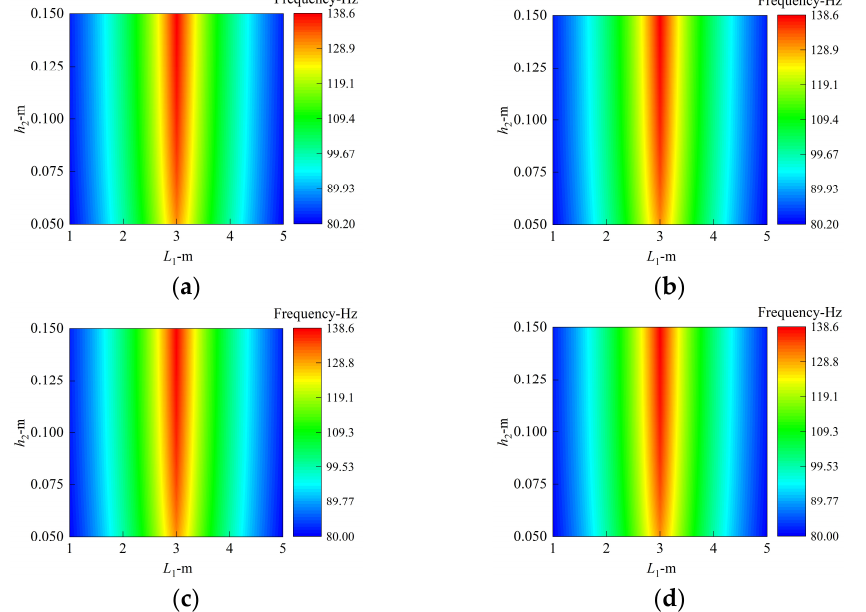
Figure 6. The first frequency value with respect to thickness and position of middle annular plate. ( a ) Clamped boundary. ( b ) Simply supported boundary. ( c ) Shear–diaphragm boundary. ( d ) Free boundary.